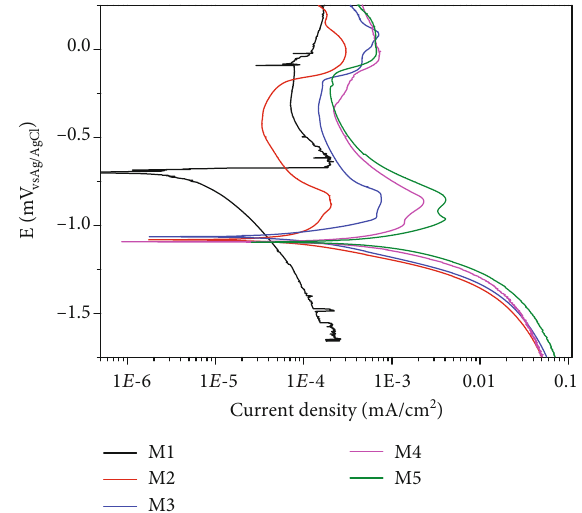
Figure 9: Polarization curves for aluminum-based alloy doped with Mn and Co after heat treatment at 600 ° C immersed in 3M KOH.